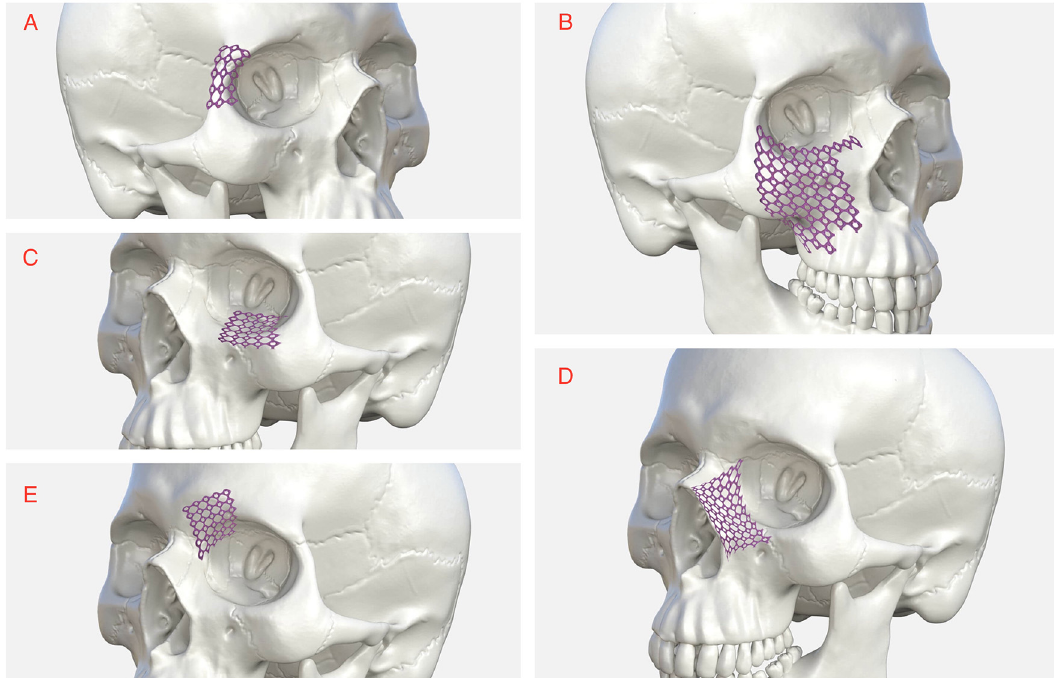
Fig. 6. Skull diagrams of presented cases with location of comminuted fracture and titanium mesh adaptation. (A) Lateral orbital rim, (B) Zygomaticoorbital complex, (C) Orbital fl oor, (D) Lateral nasal wall and media maxilla, E anterior frontal bone and medial orbital